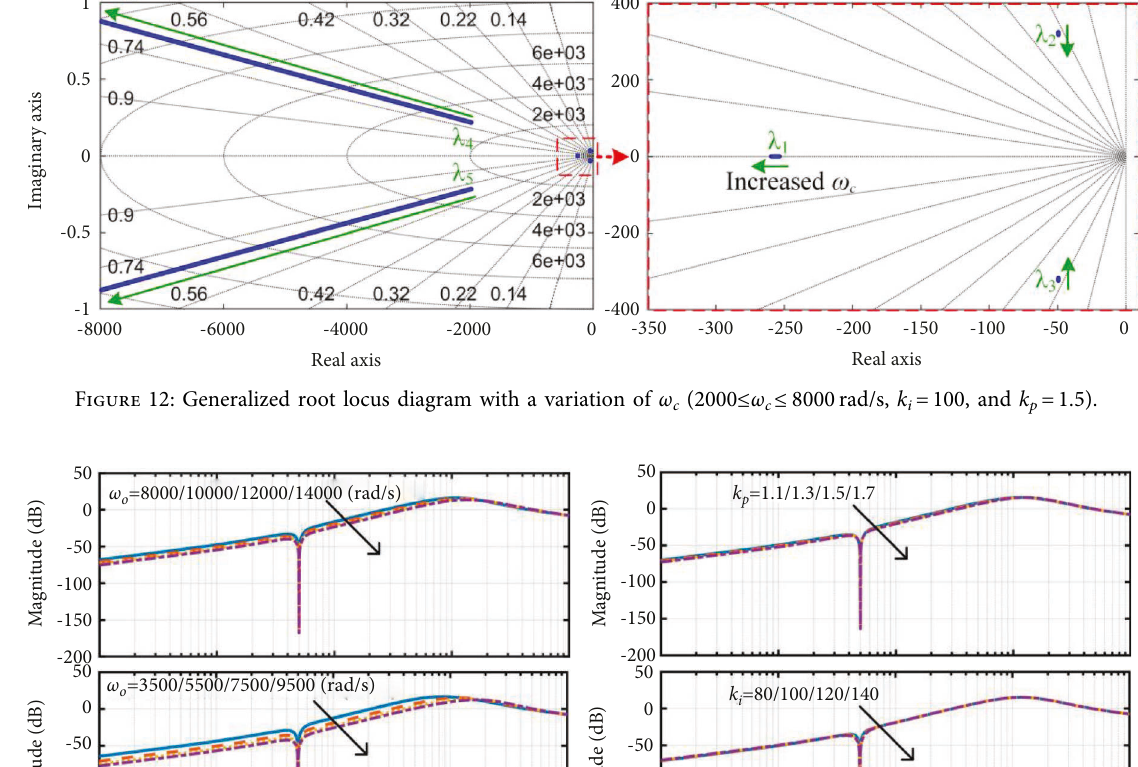
Figure 13: Bode magnitude plots of v o (s)/ d (s). (a) Variation of ω o and ω c and (b) variation of k p and k i .